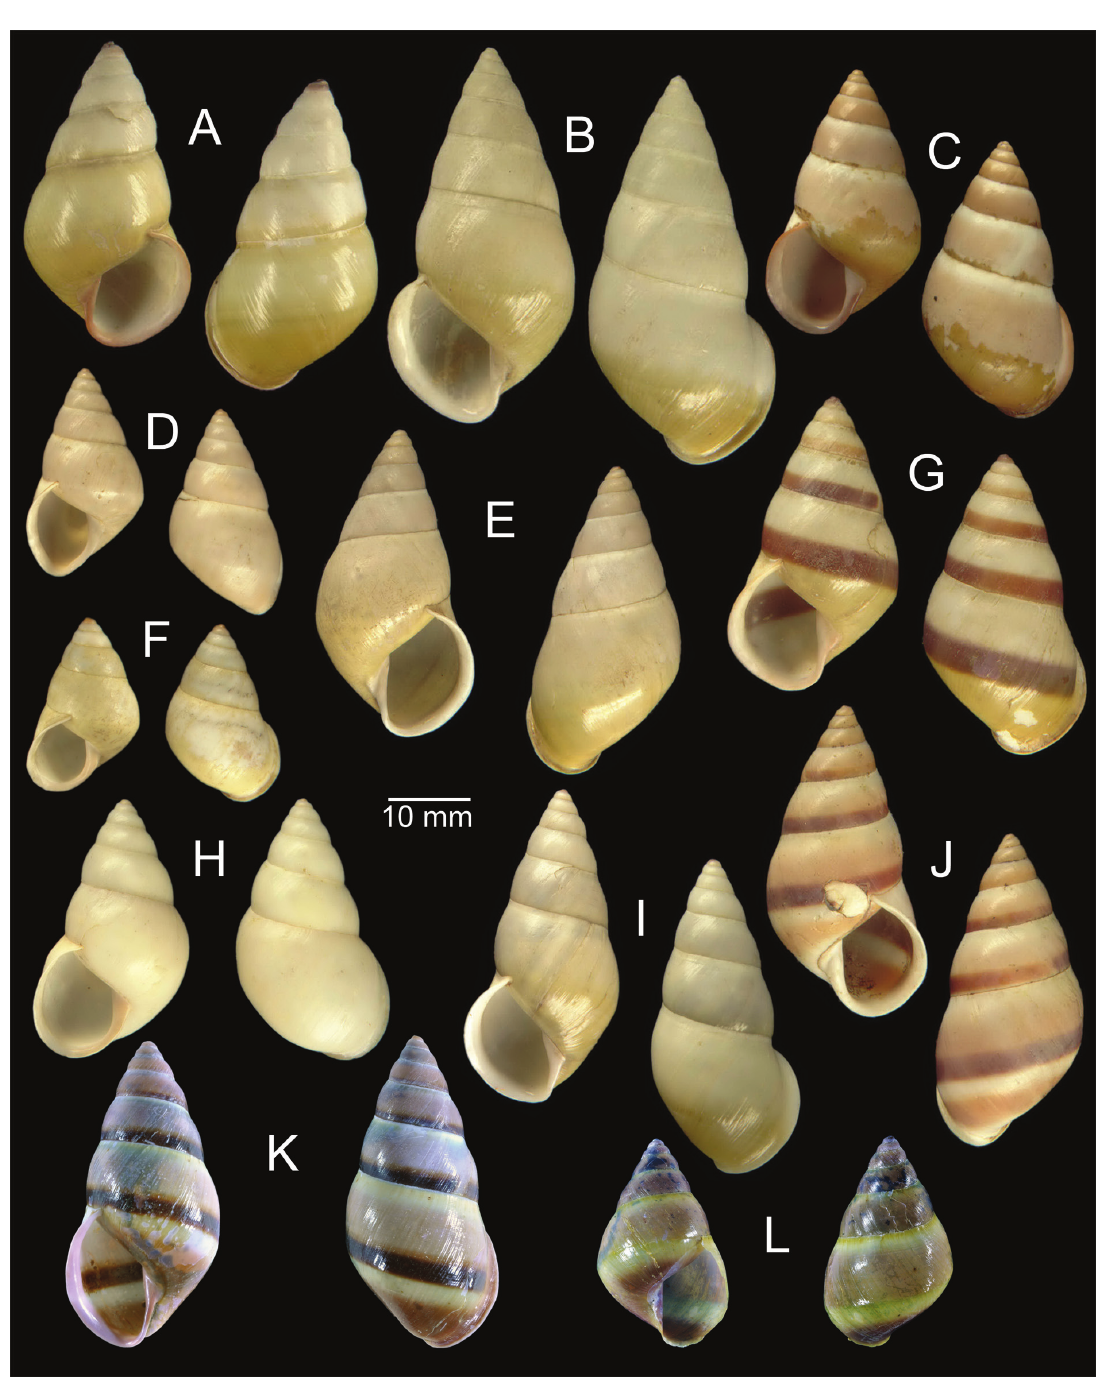
Fig. 5. Shells of Amphidromus pervariabilis Bavay & Dautzenberg, 1909. A–B . Syntype of